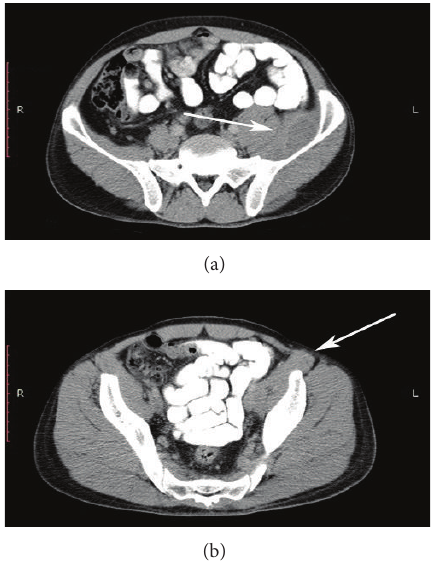
Figure 2: Repeat CT sections after 3 weeks showed significant reduction of hematoma. White arrows in the pictures highlight left iliopsoas hematomas reduction and the reduction of its inguinal